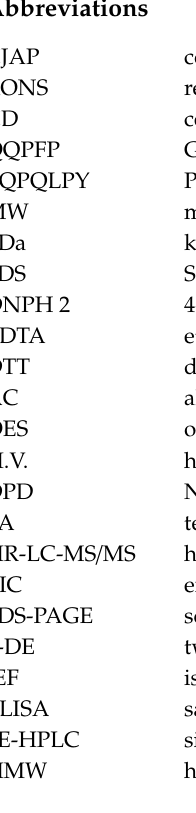
s1. Figure S1. HR-LC chromatogram analysis of CJAP plasma-modified QQPFP and PQPQLPY identified by Orbitrap HR-LC-MS / MS at treatment times of 0 min, 5 min, 10 min, 30 min and 60 min, respectively. (A) QQPFP, (B) PQPQLPY. The black arrow indicates CJAP plasma-modified products of two celiac-toxic peptides. Figure S2. Two model peptides QQPFP and PQPQLPY modified by CJAP plasma. (A) The changes in the HR-LC-MS / MS peak area of QQPFP and PQPQLPY with the di ff erent treatment time. (B) The changes in HR-LC-MS / MS peak area of products P5~P7 from PQPQLPY with di ff erent treatment time. Figure S3. Extract ion chromatograms (EIC) Figure S4. SDS–PAGE analysis of the gliadins in wheat with di ff erent CJAP plasma treatment times. M: Protein molar mass standard, lane 1: 0 min treatment, lane 2: 5 min treatment, lane 3: 10 min treatment, lane 4: 30